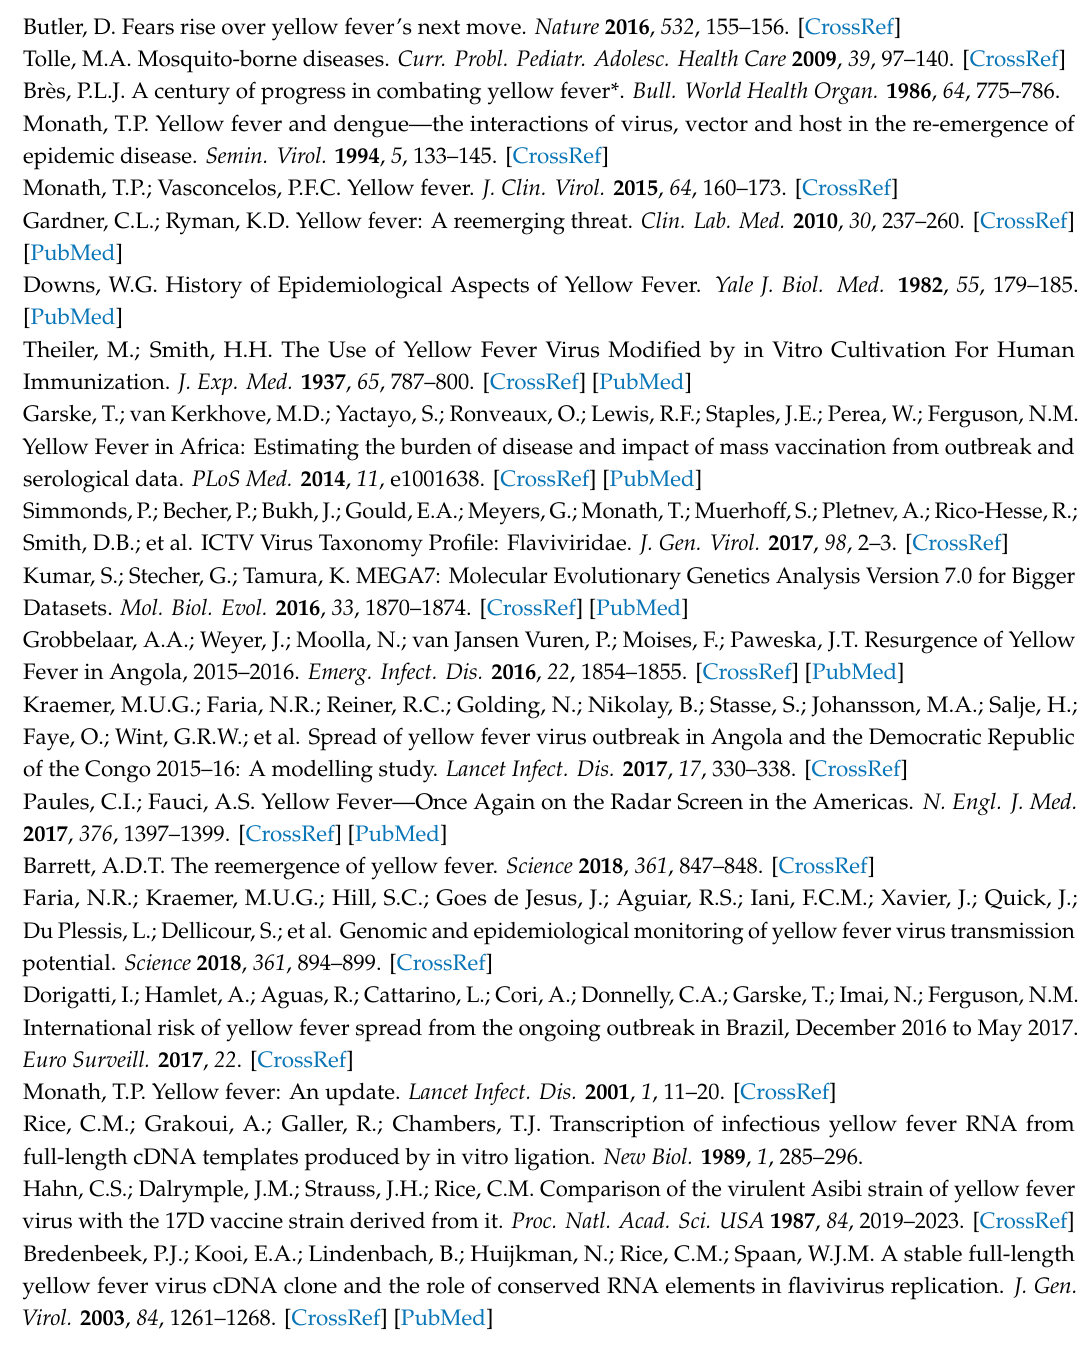
Table S1: Summary of structural and functional properties of YFV